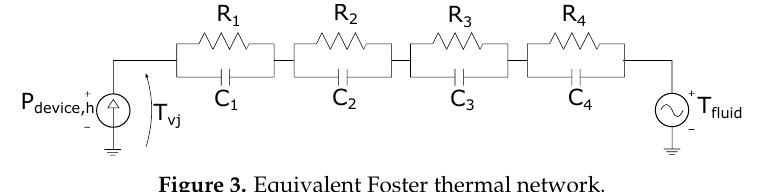
Figure 3. Equivalent Foster thermal